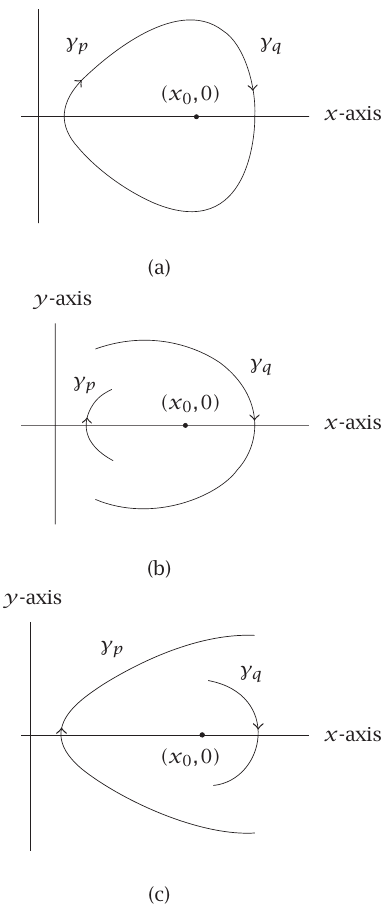
Figure 5.8 . The local behaviour of γ q and γ p